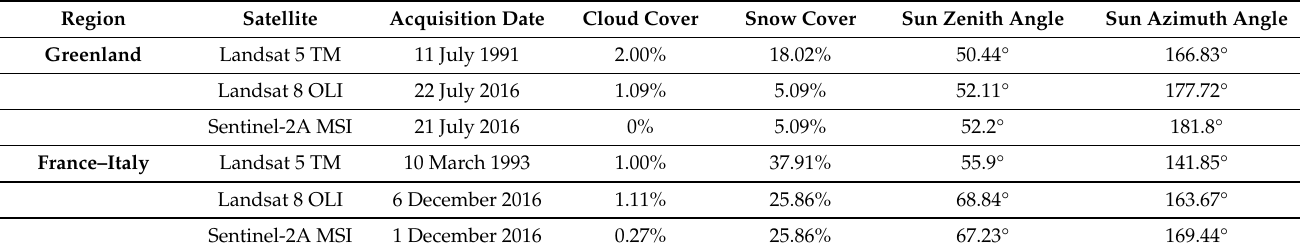
Table 1. Summary of the relevant data for Landsat and Sentinel-2A imagery in the Greenland and France–Italy regions. Region